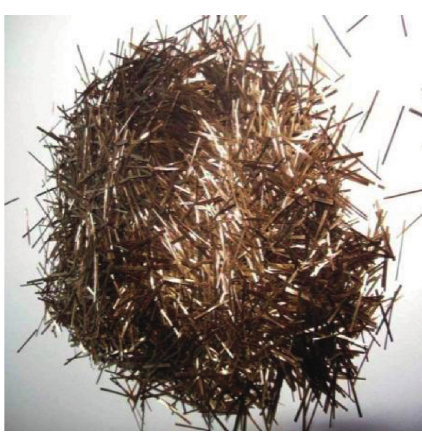
Figure 2: Basalt fiber. Table 4: The performance parameter of basalt